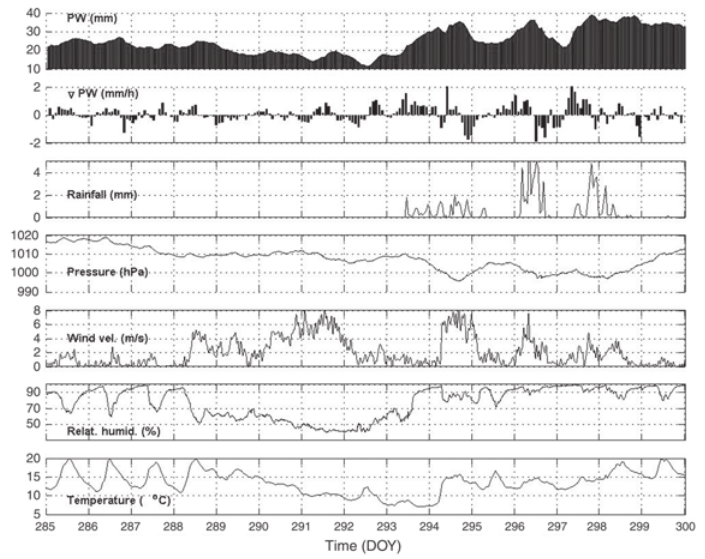
Fig. 3. Precipitable Water (PW, mm) and PW curve derivative coefficient sign ( ∇ PW, mm/h) for Padua; barometric pressure (hPa); wind velocity (m/s); relative humidity (%) and air temperature at 2 m ( ° C) for Verona versus time for period of DOY 285-300, 12 October - 27 October,